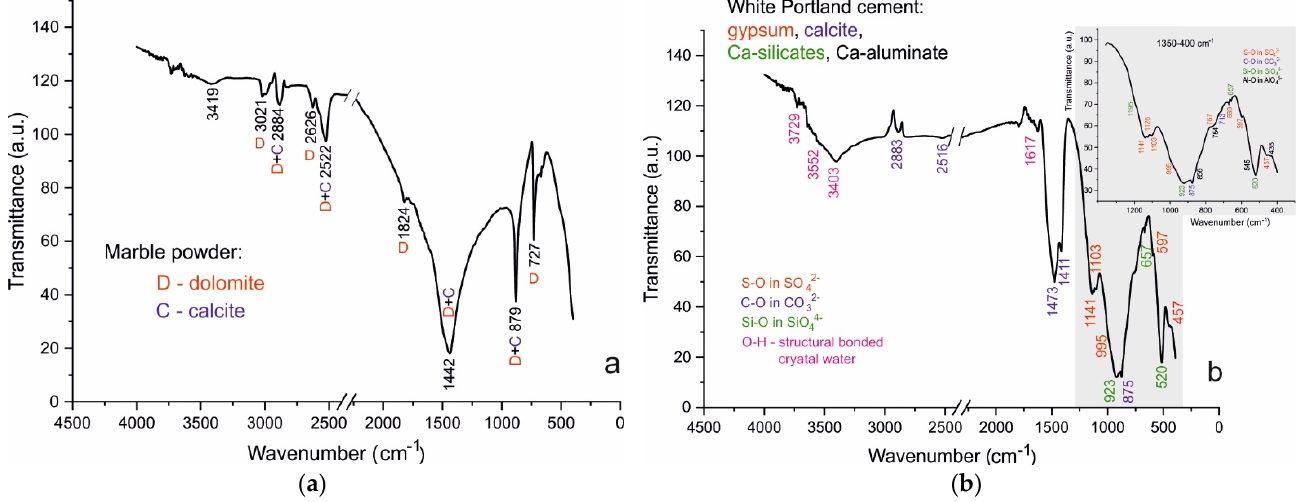
Figure 5. FTIR spectra of A028, B028, and C028. Magnifications: spectral ranges 1300–900 cm − 1 , and 900–350 cm − 1 .